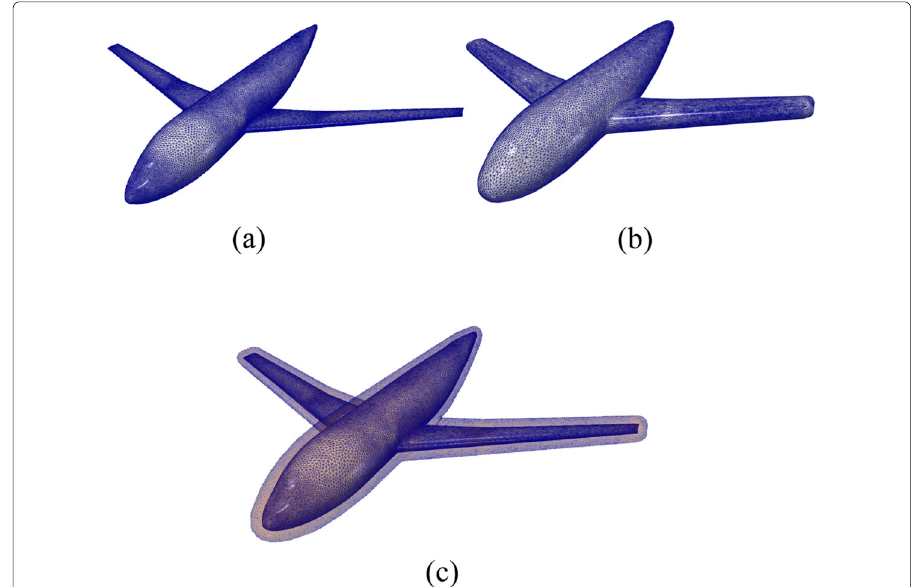
Fig. 2 Illustration of the Minkowski Sum boundary surface (envelope surface). ( a ) The original surface mesh (viscous wall). ( b ) The Minkowski Sum boundary surface. ( c ) The combination of the Minkowski Sum boundary surface and the original